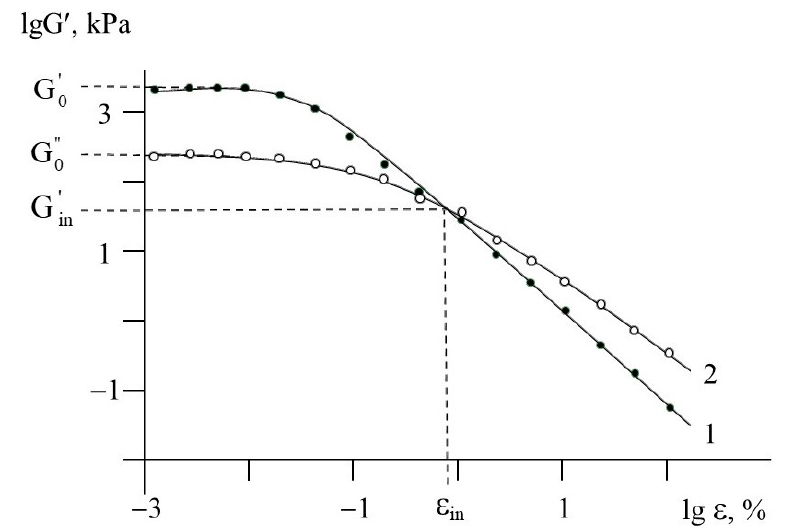
Figure 5. Strain dependences of storage modulus G (cid:48) 0 (1) and loss modulus G (cid:48)(cid:48) 0 (2) for kaolinite- PDADMAC sample. 78 wt.% kaolinite aqueous suspension, pH Table 1. Rheological characteristics of kaolinite-polymer samples.